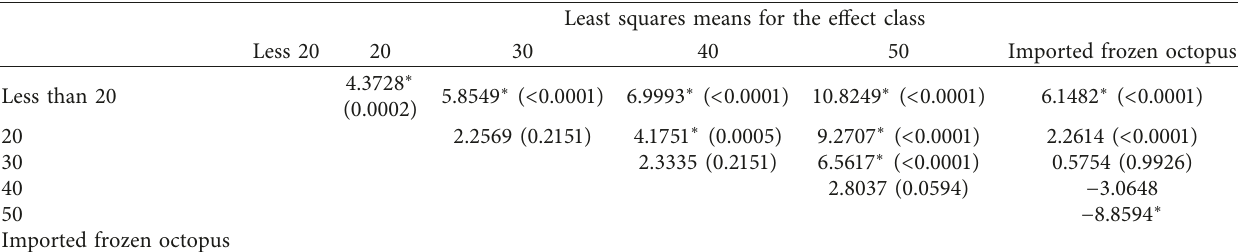
Table 2: Statistical analysis of dielectric properties measured at 500 MHz and the trunk part from adulterated and imported frozen Octopus minor